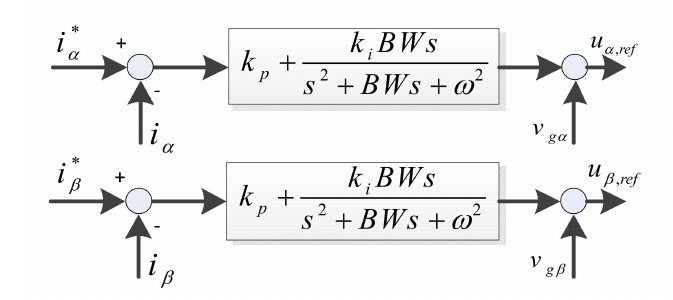
Figure 7. Standard non-ideal PR controller in the stationary reference frame.